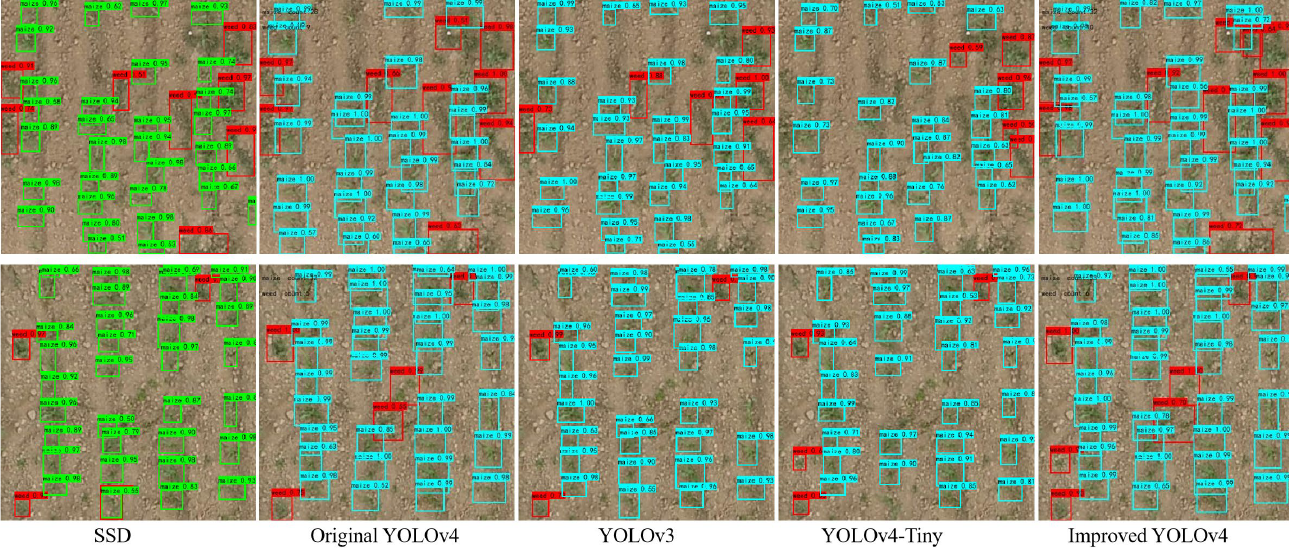
Figure 10. Comparison of prediction maps from different models. The red labels are weeds, and the blue and green labels are maize.